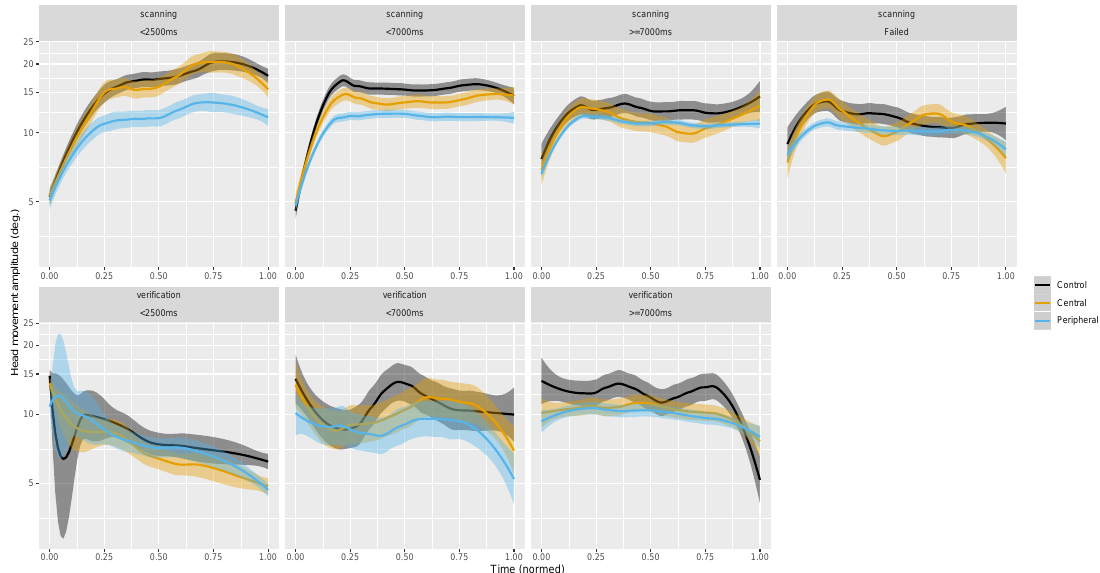
Figure 6. Time-course of average head movements amplitude during saccades as a function of search phase (trial duration subgroups do not overlap, see FIgure A3, Appendix D). Ribbons show 95%CI. Control condition appears in black, central masking in orange and peripheral masking in